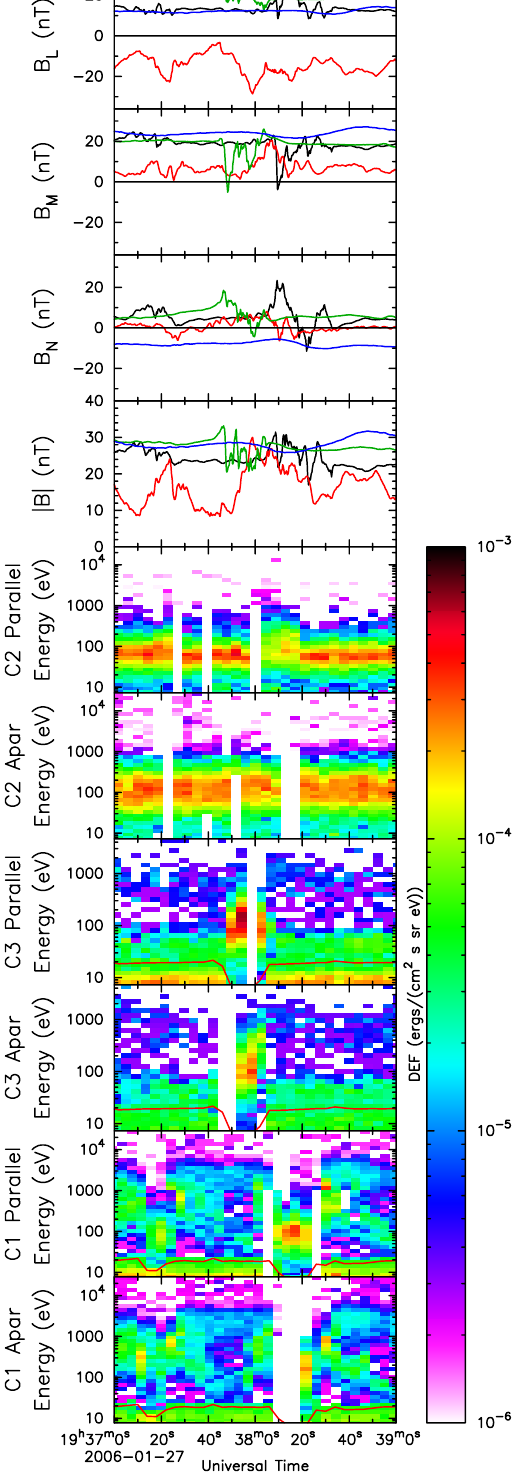
Fig. 8. An enlargement of the FTE signatures observed by the four Cluster spacecraft at 19:38UT, taking the same format as Fig.